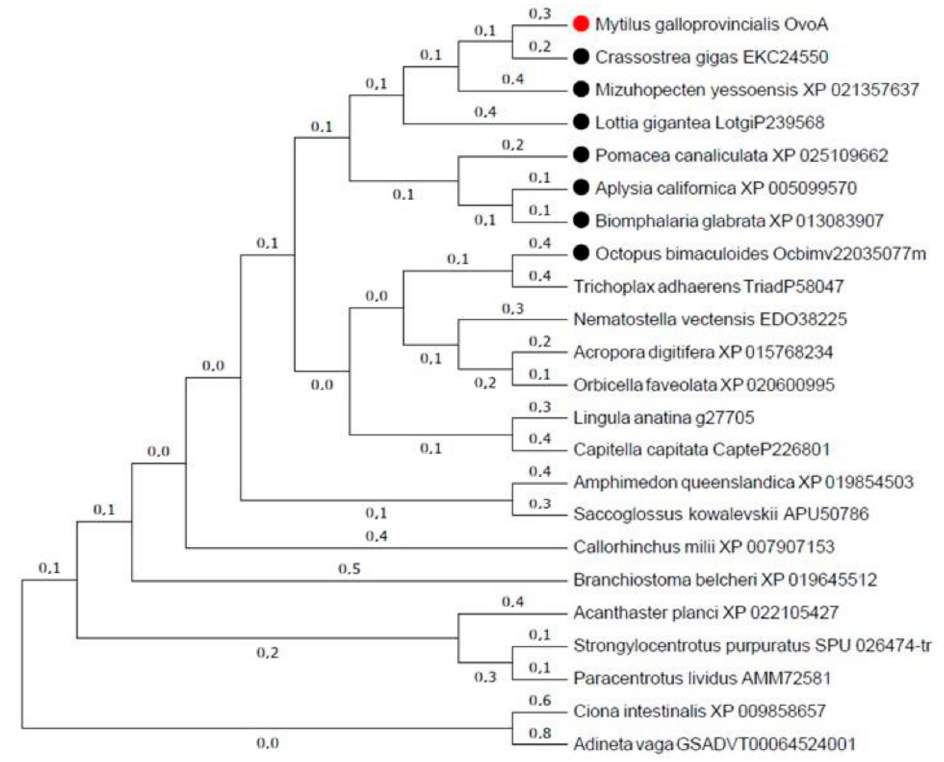
Figure 1. Phylogenetic tree showing the relationship between di ff erent animal-deduced ovothiol synthase protein sequences. Name of species is shown together with protein accession numbers either in Genbank or in Ensembl. All mollusc sequences are labelled with a dot. The evolutionary history was inferred by using the Maximum Likelihood method based on the JTT matrix-based model. The tree with the highest log likelihood ( − 11084, 7135) is shown. Initial tree(s) for the heuristic search were obtained automatically by applying Neighbor-Join and BioNJ algorithms to a matrix of pairwise distances estimated using a JTT model, and then selecting the topology with superior log likelihood value. The analysis involved 23 amino acid sequences. All positions containing gaps and missing data were eliminated. There was a total of 312 positions in the final dataset. Evolutionary analyses were conducted in